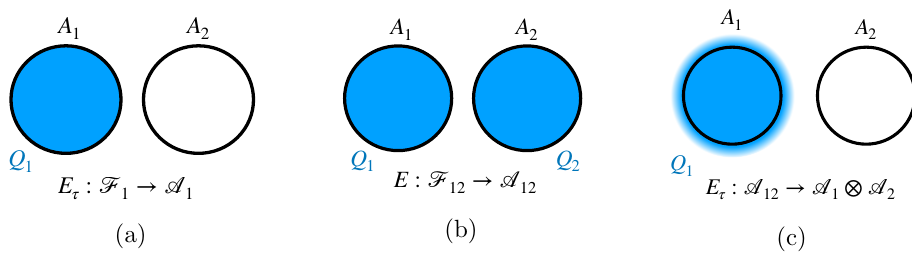
R c ( x ) j ( x ) where j ( x ) is the charge density and the region Figure 5. Consider the operator e ig x 2 B B is the blue region. (a) On a lattice we pick c ( x ) = 1 that is the twist operator (cid:28) g = e igQ 1 . It generates the action of the symmetry group on the local algebra of A 1 . Averaging over (cid:28) g is a conditional expectation that projects F 1 to A 1 . (b) The action of the symmetry on the region A 12 is given by e ig ( Q 1 + Q 2 ) . Averaging over this unitary projects from F 12 to A 12 c) In a QFT choosing c ( x ) = 1 in A 1 and c ( x ) = 0 outside of A 1 leads to an operator that has a violent behavior at the boundary of A 1 due to the discontinuity in c ( x ). If there is a gap between A 1 and A 2 we can choose a c ( x ) = 1 inside A 1 and make it smoothly fall out to zero without entering region A 2 . This is the analog of the twist operator in a QFT. Averaging over this twist projects from A 12 down to A 1 (cid:10) A 2